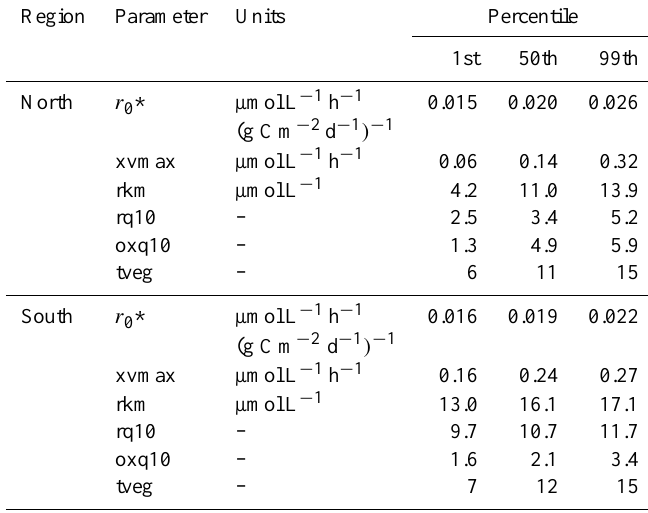
Table 1. Parameter distributions used in the Walter and Heimann (2000) CH 4 model.